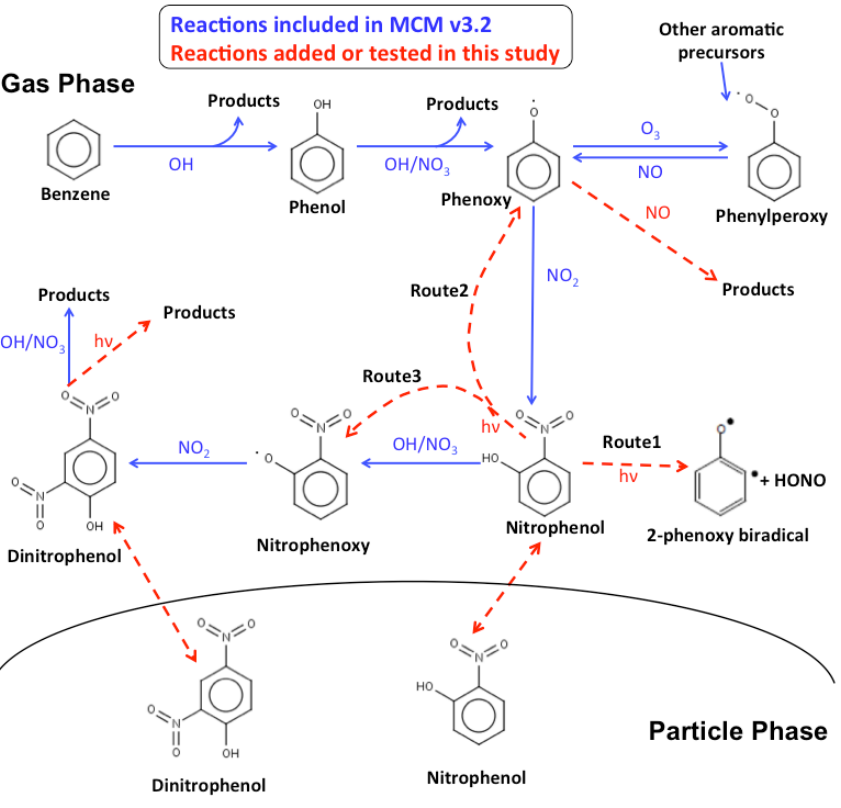
Figure 1. Formation of phenol, nitrophenol (NP), and dinitrophenol (DNP) from the photooxidation of benzene in the atmosphere (Jenkin et al., 2003). Reactions in blue are included in the MCM v3.2, whereas reactions in red are added or evaluated in this study. For NP, DNP, and the intermediate radicals, other isomers are expected but not shown for the sake of